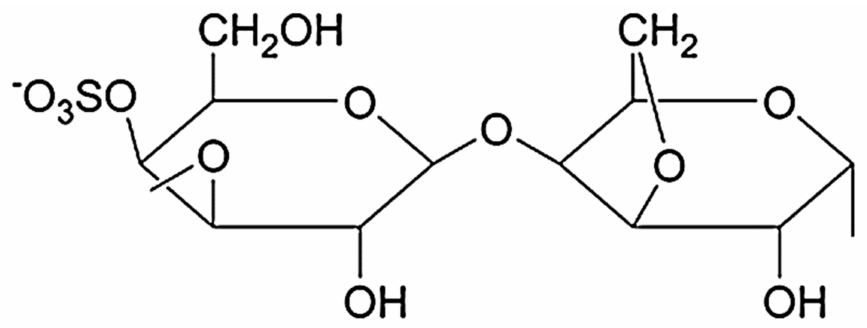
Figure 4. Representative of carrageenan structure ( κ